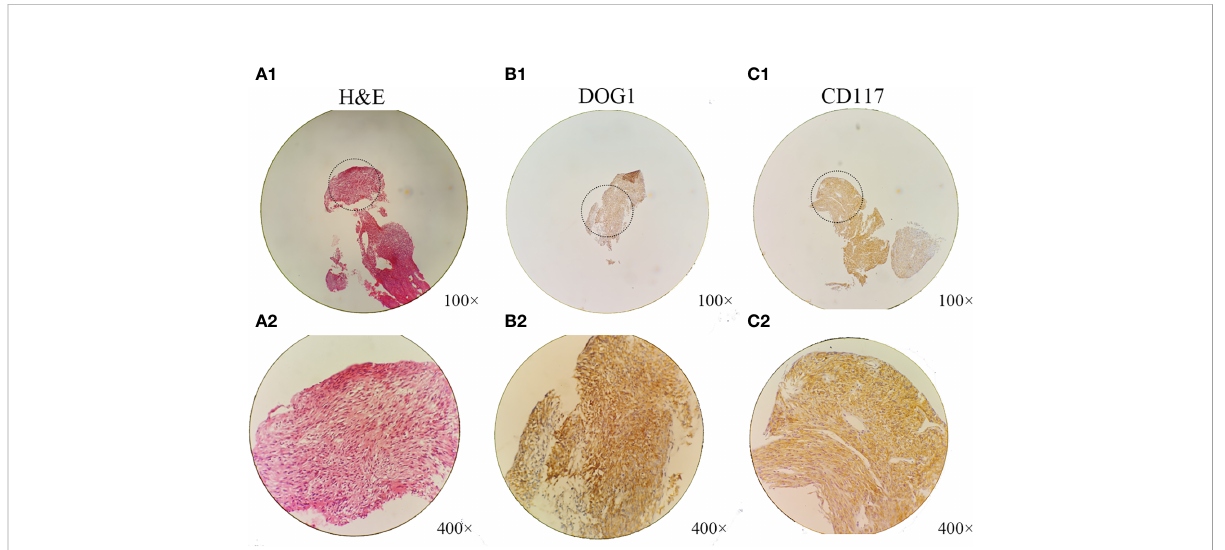
FIGURE 2 Histological and immunohistochemical analyses of the hepatic extra-gastrointestinal stromal tumor. (A1, A2) Microscopically, the tumor consisted of spindle cells with pleomorphic nuclei arranged into fascicles (hematoxylin – eosin stain; A1, ×100 magni fi cation; A2, ×400 magni fi cation). The patient ’ s hepatic extra-gastrointestinal stromal tumor had the following immunohistochemical staining pro fi le: (B1, B2) DOG1, (C1, C2) CD117 + ( B1 , C1 , ×100 magni fi cation; B2 , C2 , ×400 magni fi